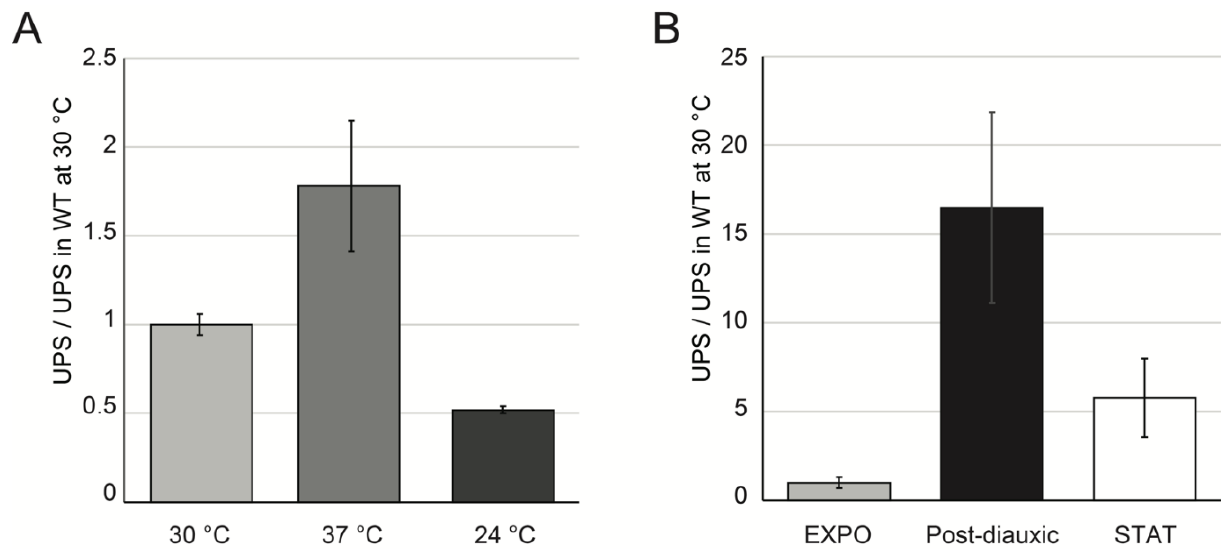
Figure 4. UPS transcripts accumulated in various growth conditions. ( A ) High temperature increased UPS level. Total RNA was extracted from wild-type cells cultivated overnight to exponential phase in YPD at indicated temperatures. UPS level was quantified as in Figure 1C. Error bars correspond to the standard deviation of three independent cultures. ( B ) UPS accumulated in post-diauxic and stationary (STAT) wild-type cells. Cells were grown in YPD at 30 ◦ C overnight to the exponential phase (EXPO) and then left for either an additional 24 h or 11 days. RNA extraction and experimentation was performed as in Figure 1C, data were normalized by scR1 RNA reverse transcribed with specific primer (scR1-R),and quantified with an scR1F/R couple. scR1 -normalized values were represented as a ratio of WT exponential values. Error bars correspond to the standard deviation of three independent cultures.